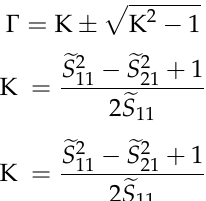
Figure 7. Diagram of in-waveguide experimental setup.